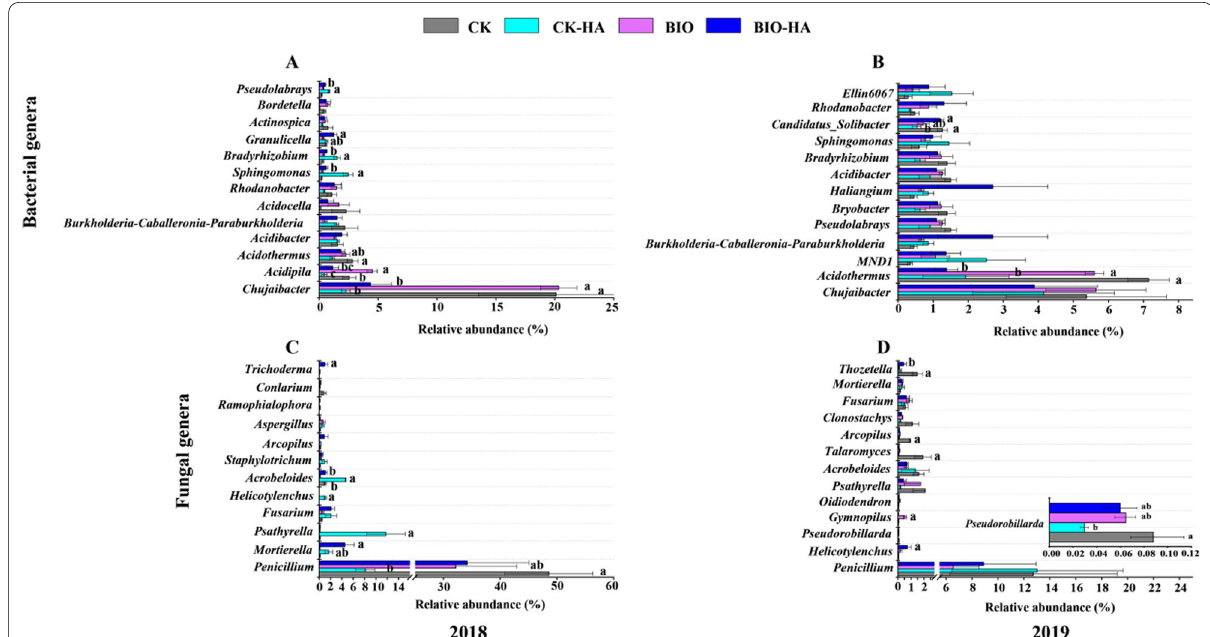
Fig. 4 Relative abundance of the 15-dominant bacterial ( A and B ) and fungal ( C and D ) genera 2018–2019. CK, conventional fertilization; CK-HA, conventional fertilization combined with humic acid; BIO, bio-organic fertilizer; BIO-HA, combined application of BIO and HA. Different lowercase letters indicate significant difference at 0.05 levels (LSD, P < 0.05). The error bars are the standard errors (n